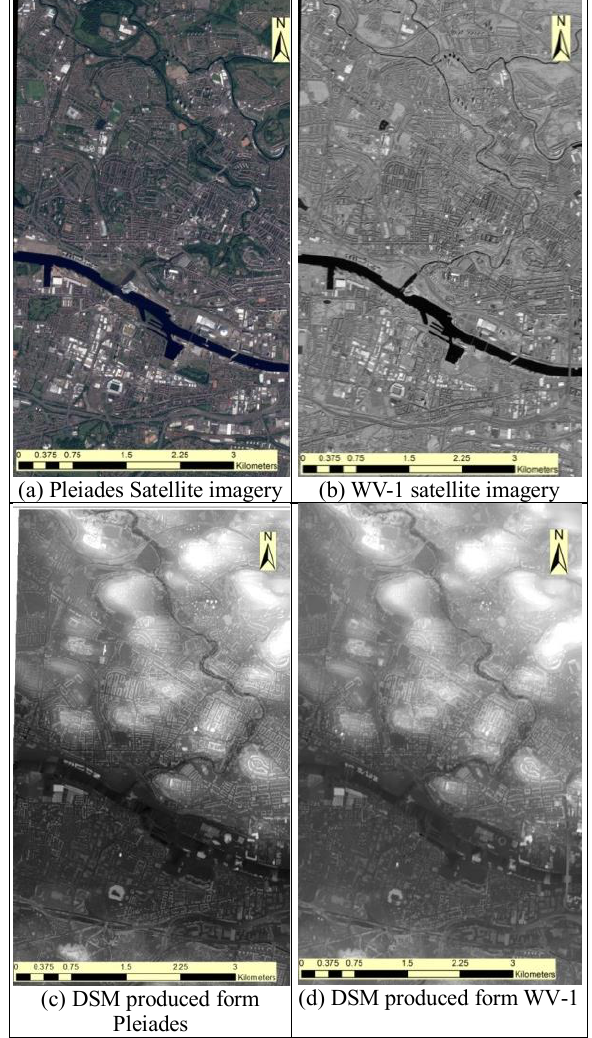
Figure 1. Study area and study data used in merging